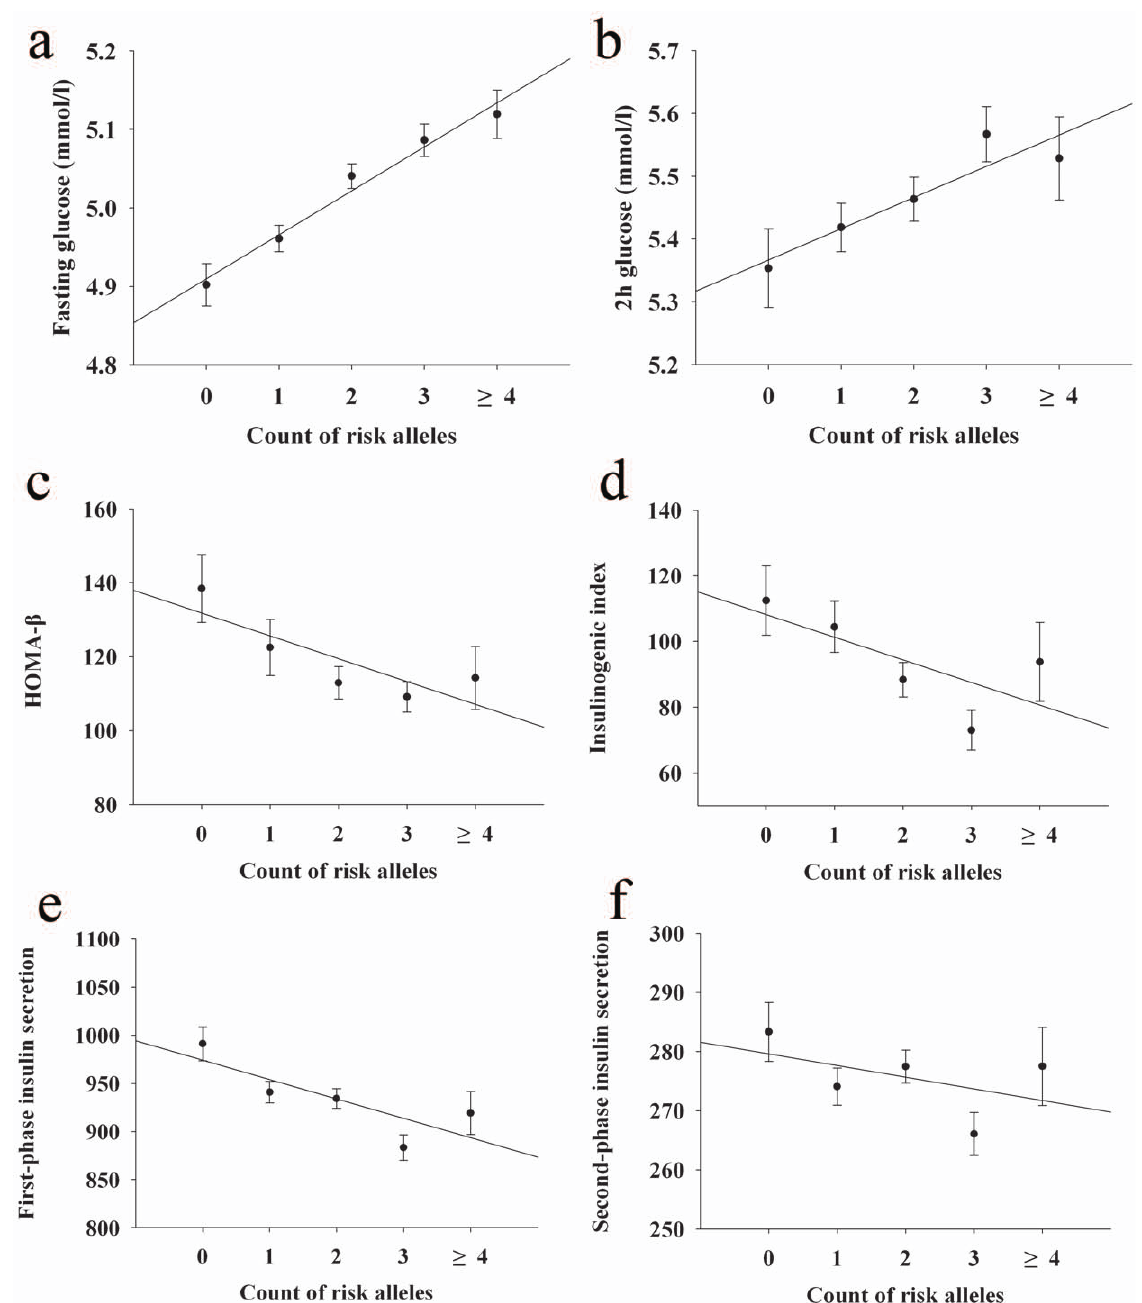
Figure 1. Combined effect of risk alleles for high fasting glucose from GCK rs1799884, G6PC2 rs16856187 and MTNR1B rs10830963 on quantitative traits. (a) fasting glucose ( n =3,212); (b) 2 h glucose ( n =3,212); (c) HOMA- b ( n =2,304); (d) insulinogenic index ( n =953); (e) first- phase insulin secretion ( n =2,294); (f) second-phase ( n =2,294) insulin secretion. Data shown are mean 6 SE. Individuals carrying more risk alleles for high fasting glucose tended to have higher glucose levels at both fasting ( p =1.7 6 10 2 13 ) and 2 h during OGTT ( p =0.0009), lower HOMA- b ( p =0.0011), insulinogenic index ( p =0.0017), first- ( p =1.1 6 10 2 7 ) and second-phases ( p =0.0321) of insulin secretion.